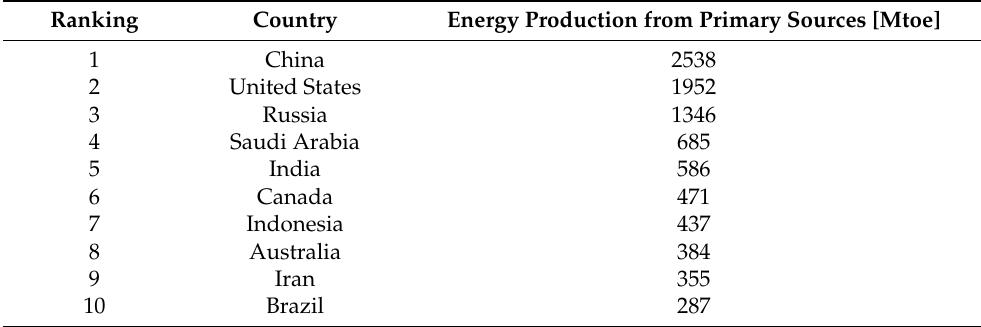
Table 3. Top-10 energy-producing countries (highest to lowest). Data of energy production are expressed in Million tons of oil equivalent (Mtoe). Data are referred to year 2016.